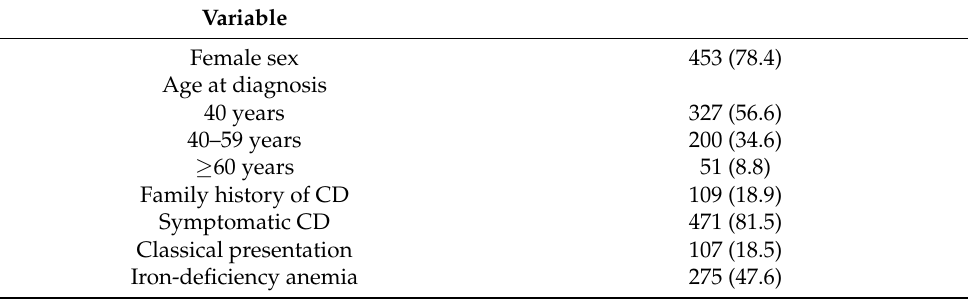
Table 1. Characteristics of patients with celiac disease (CD) at diagnosis ( n = 578). Variables are expressed as frequencies